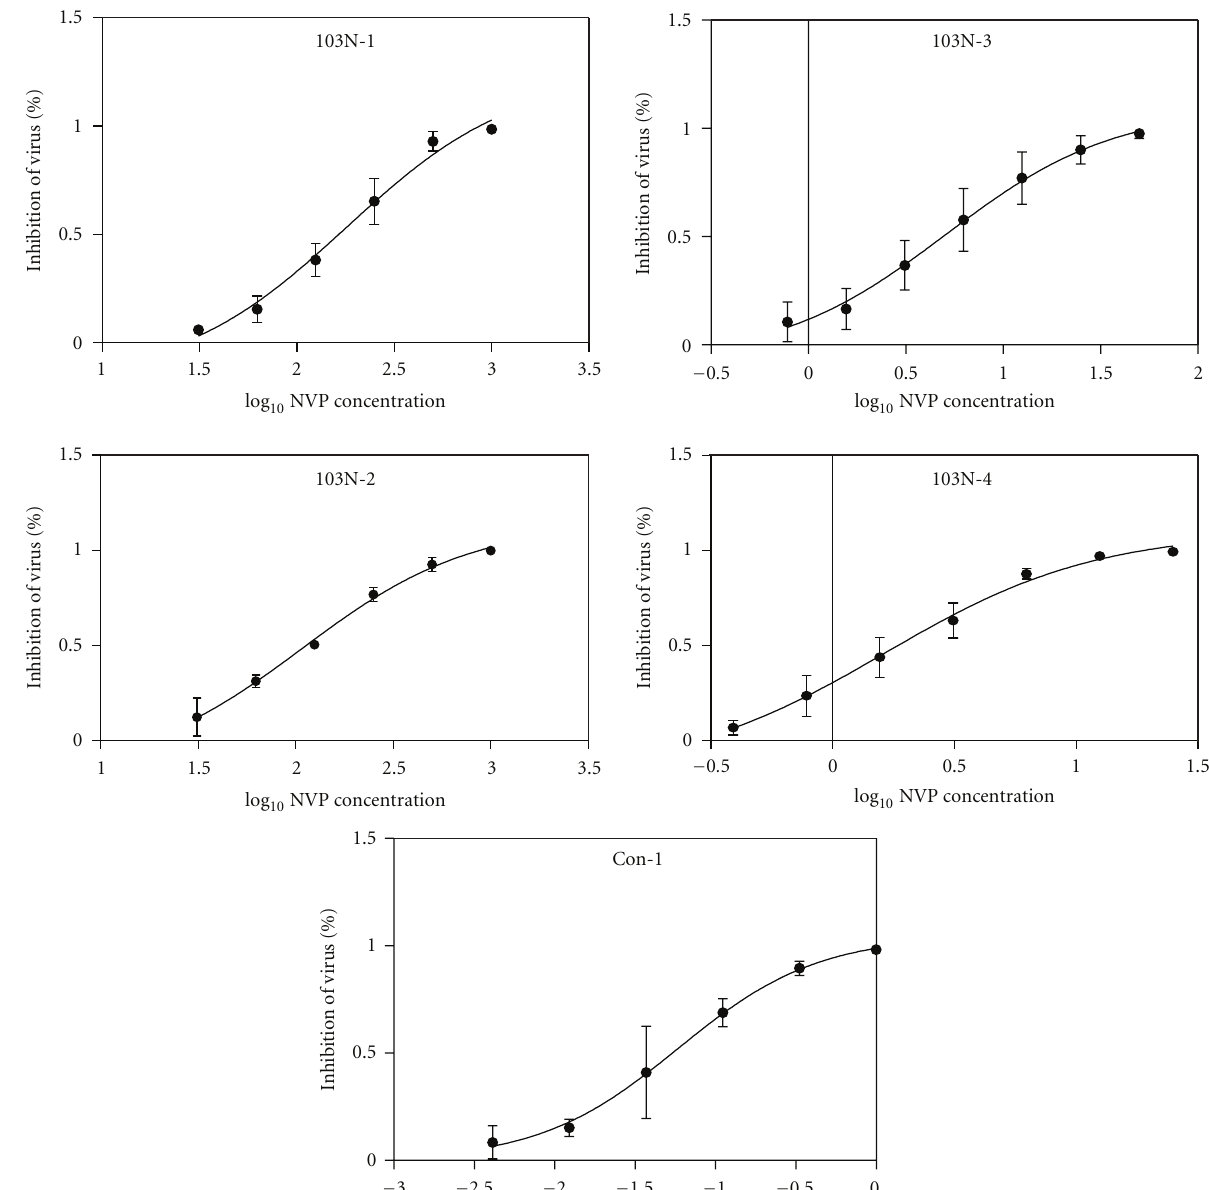
Figure 3: The curves of percent inhibition of virus 103N-1 ∼ 103N-4, Con-1 to log 10 NVP concentration.